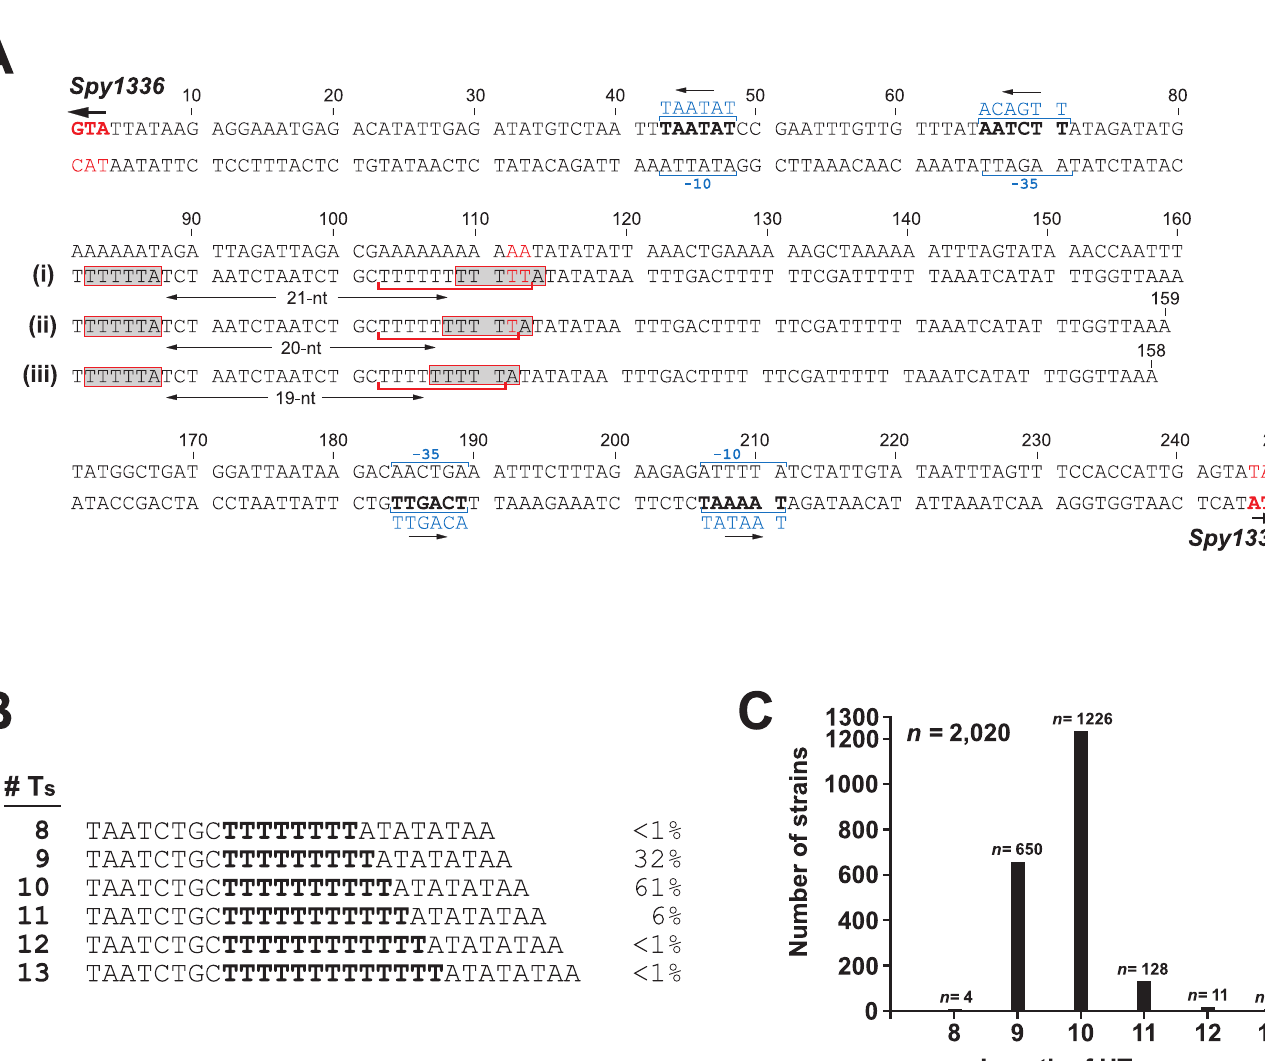
alleles differing by one T Spy1336-7